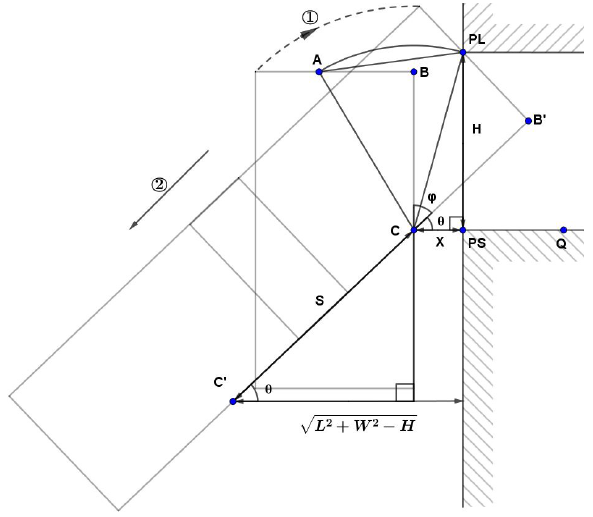
Figure 11. The illustration of calculation process of θ . X = the distance between C and PS .